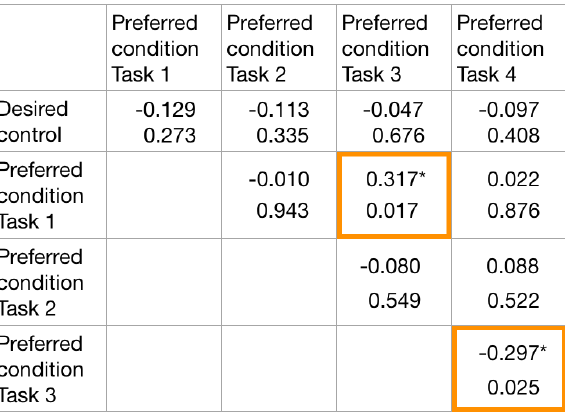
Figure 6: Correlation between desired control and the preferred conditions for each tasks.